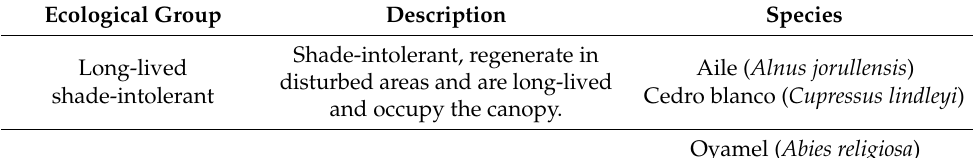
Table 4. Ecological groups following descriptions by Fredericksen et al. [51]. Ecological Group